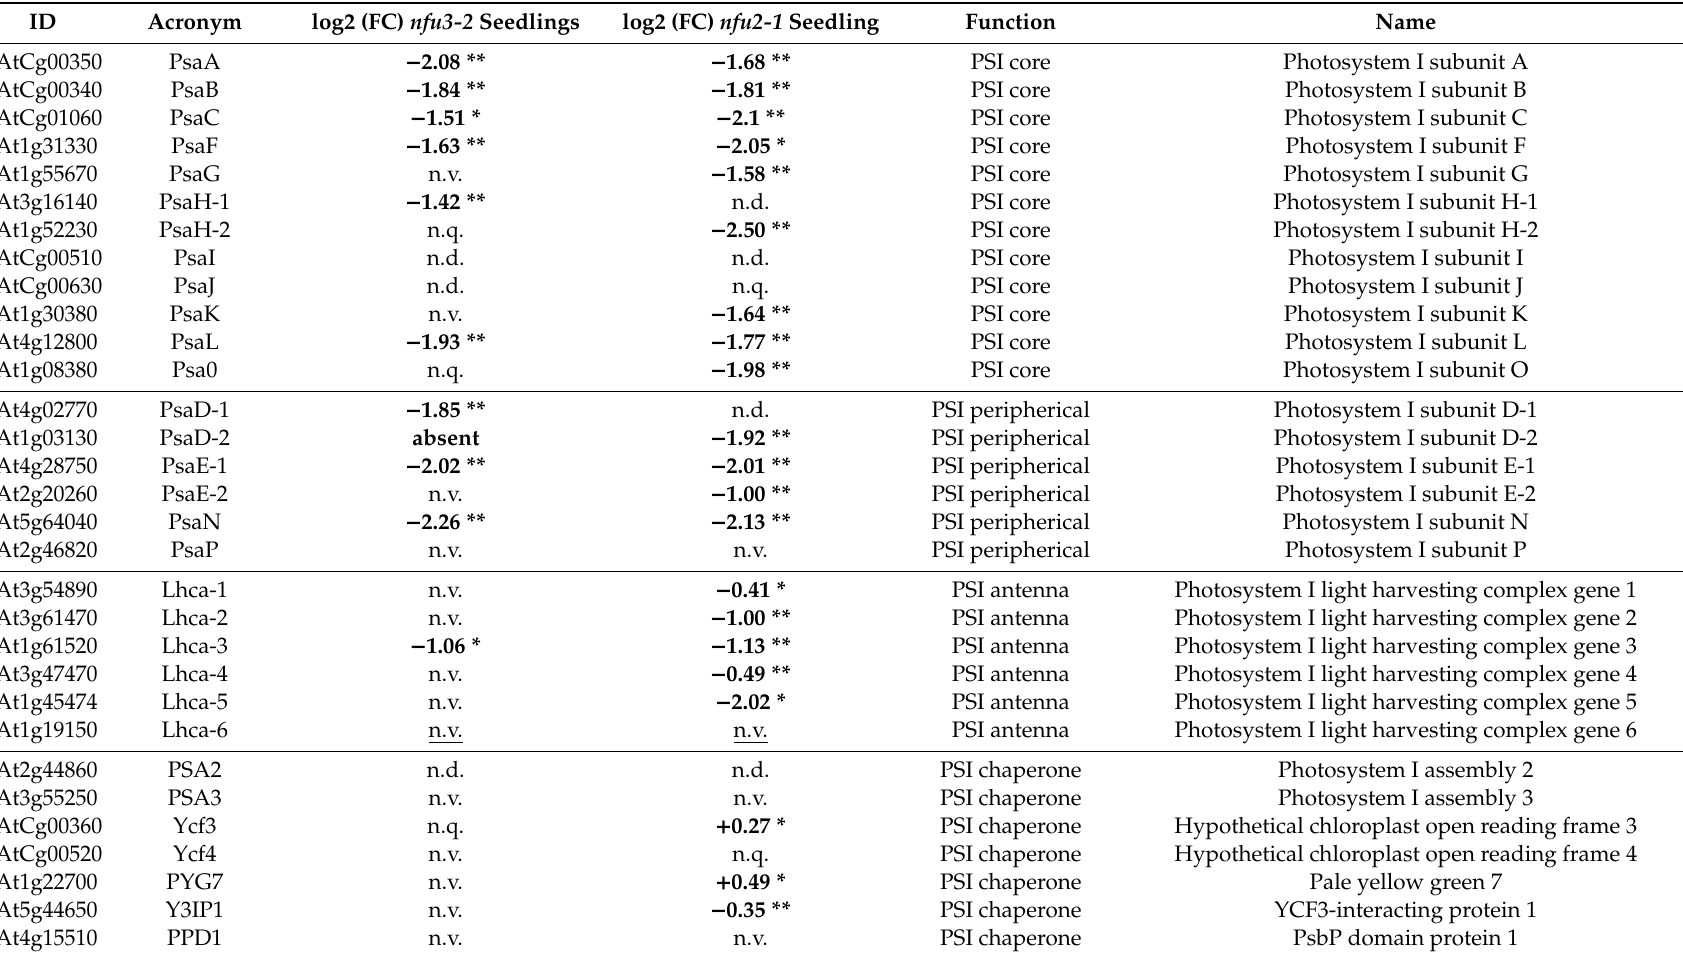
Table 1. Abundance of photosystem I- and II-associated proteins in the Arabidopsis thaliana nfu3-2 mutant relative to wild